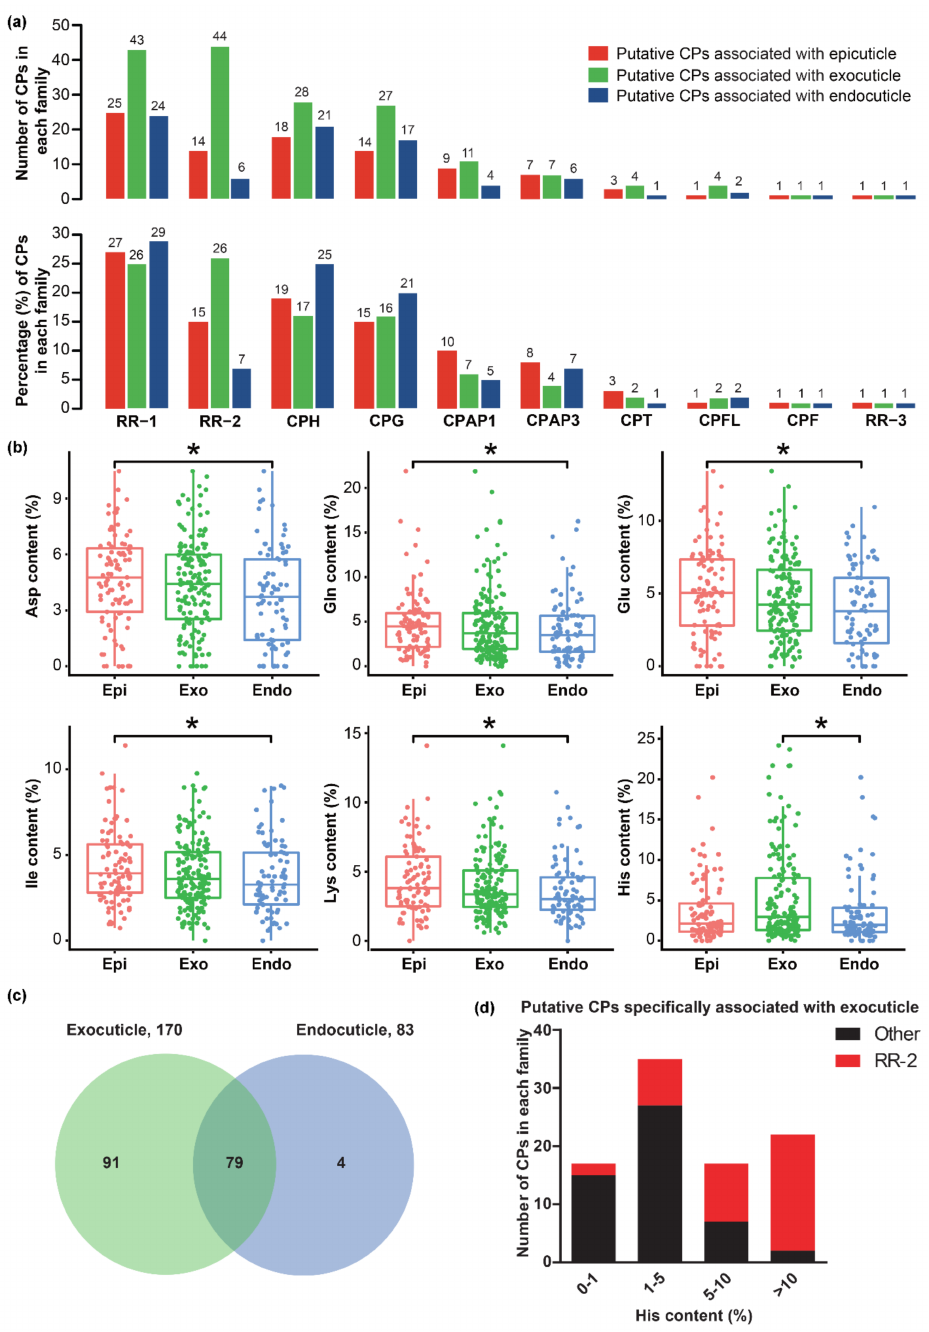
Figure 4. The putative CPs associated with epicuticle, exocuticle, and endocuticle in B . mori . ( a ) The number and percentage of putative CPs in each protein family. The red, green, and blue columns represent the putative CPs associated with epicuticle, exocuticle, and endocuticle, respectively. ( b ) Comparison of the amino acid contents among putative CPs associated with epicuticle, exocuticle, and endocuticle. The p -value was calculated by the Wilcoxon rank sum test and less than 0.05 was considered statistically significant. The asterisk indicated a significant difference between the two groups. Asp: aspartic acid; Gln: glutamine; Glu: glutamic acid; Ile: i-isoleucine; Lys: lysine; His: histidine. ( c ) Comparison of putative CPs associated with exocuticle and endocuticle; ( d ) The number of putative CPs specifically associated with exocuticle in each His content (%). The red and black column represents the CP families of RR-2 and